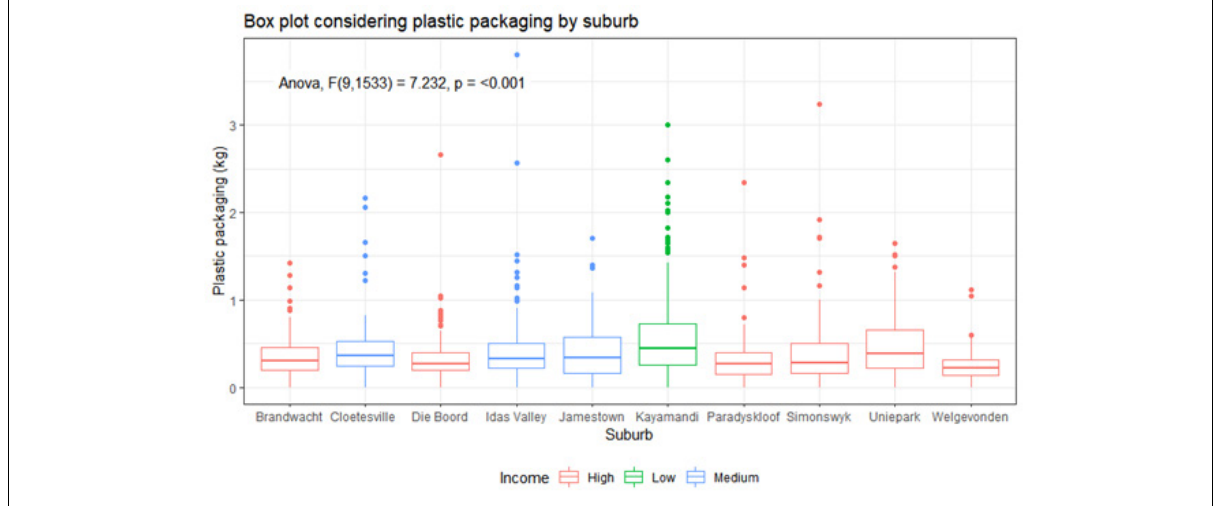
Figure 2: Box plot depicting differences in means of plastic packaging waste fractions among suburbs in Stellenbosch.